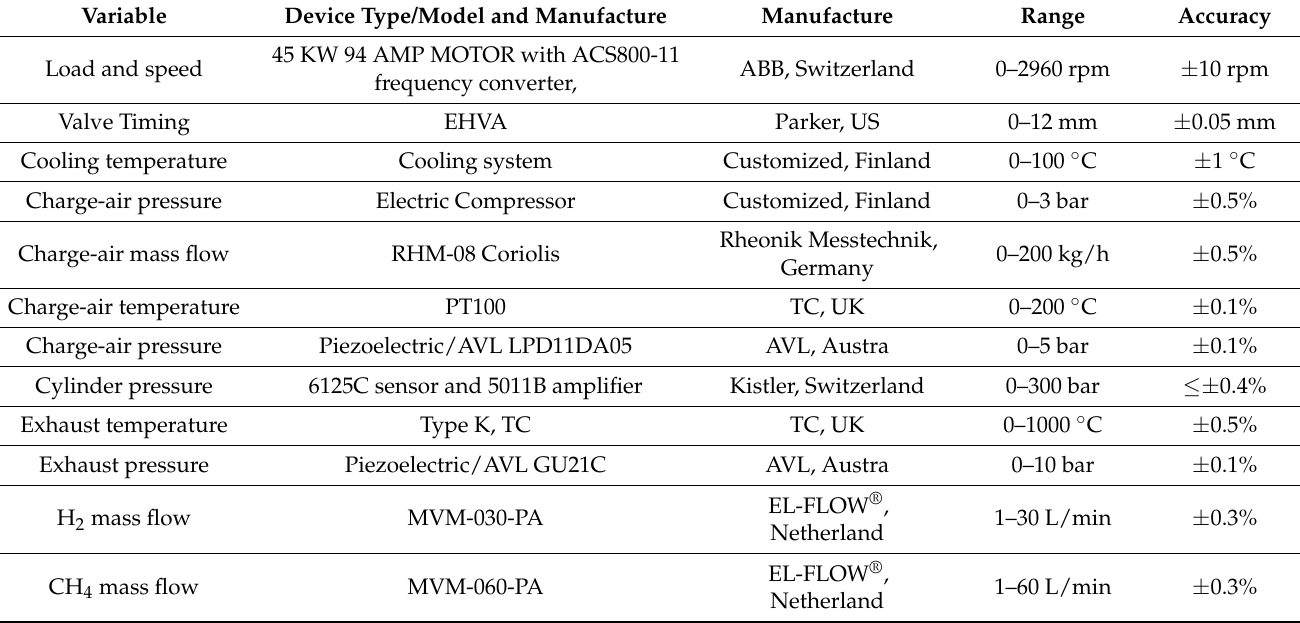
Table 2. Specification of measurement devices for controlling and monitoring the engine operating